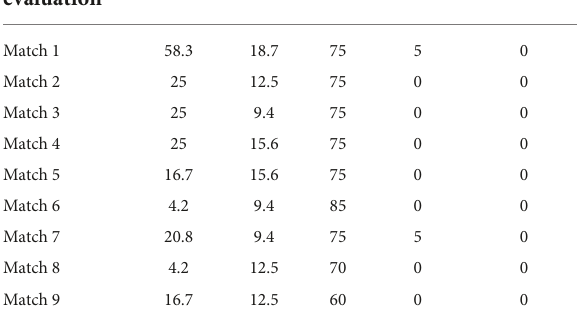
TABLE 3 Values in the POMS factors of Subject 2 after the matches. Time of